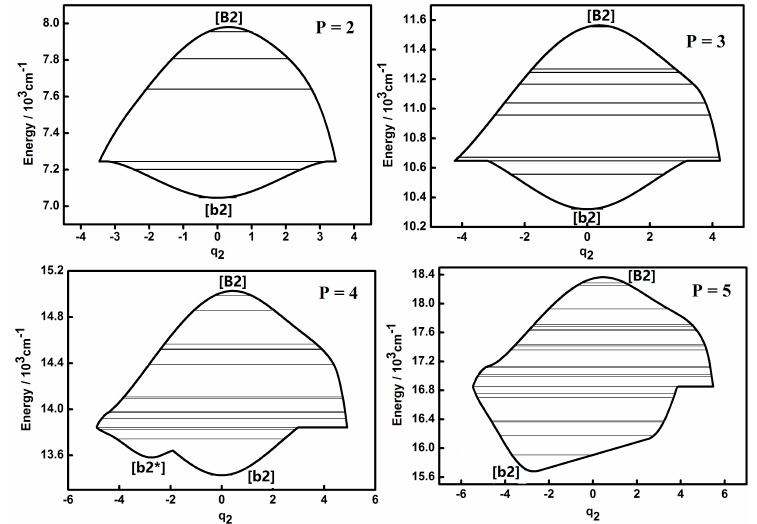
Figure 3. Dynamic potentials of the non-integrable HOCl system (obtained with H ( q 2 , p 2 , q 3 , p 3 , P ), q 2 coordinate) with P = 2, 3, 4, 5, and the energy levels included in the dynamic potential are shown by the lines.